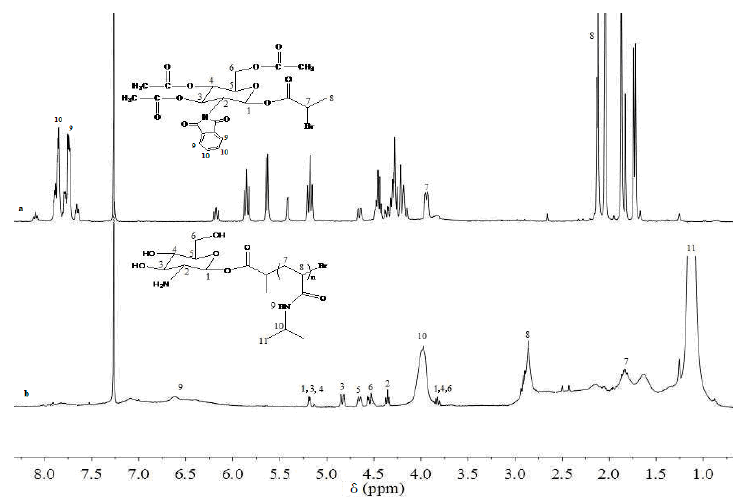
Figure 3. 1 HNMR spectra of ( a ) GA initiator (ii) and ( b ) GA-PNIPAM (ii), both in CDCl 3 .